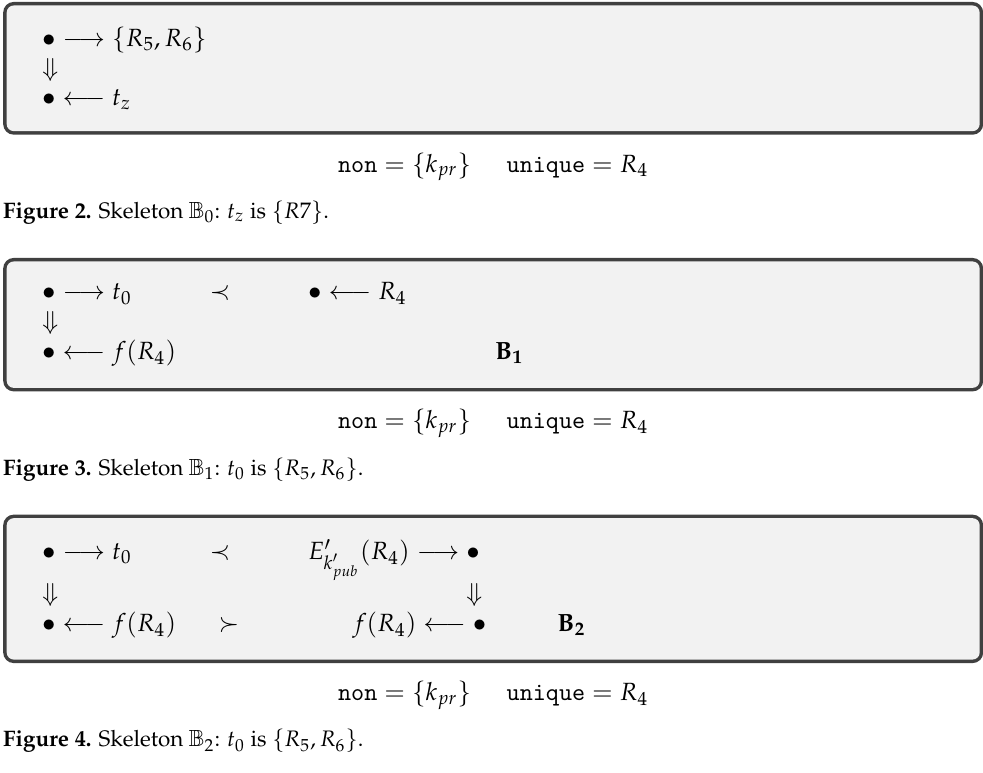
Figure 4. Skeleton B 2 : t 0 is { R 5 , R 6 }